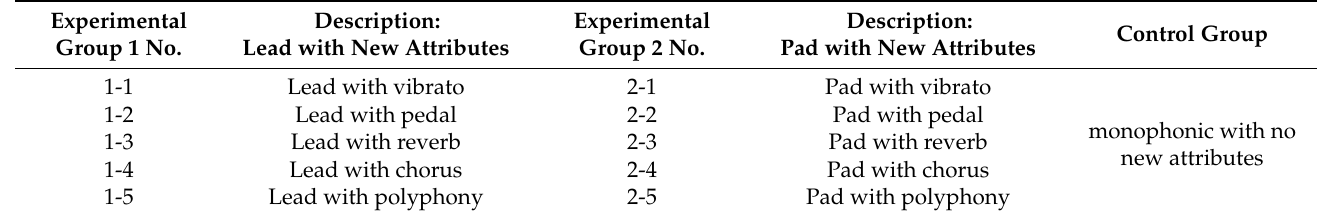
Table 3. The number and specific content of the control group and each experimental group.